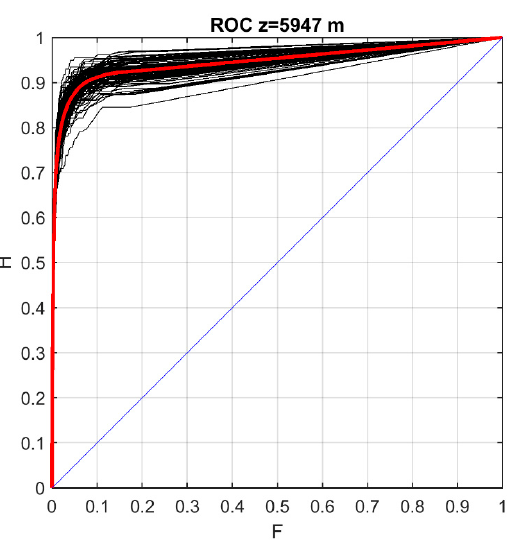
Figure 13. The 99 Receiver Operating Characteristic (ROC) curves calculated using random splitting of the data into calibration and verification data sets (black curves). Red line displays the mean ROC curve over 99 random realizations, whereas the blue line shows the random forecast. H on the y-axis depicts the hit rate, while F on the x-axis the false alarm rate (Section 2.6). The results are shown for cloud radar data covering the vertical layer of 15 gates with the center at a height z = 5947 m above the radar.